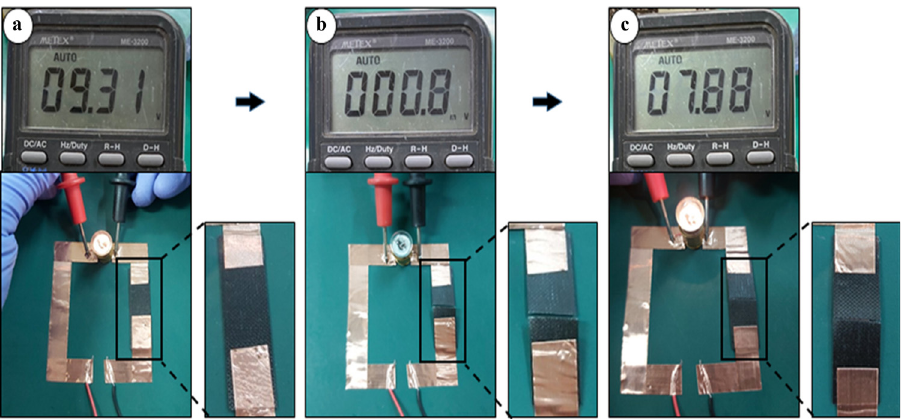
Figure 8: Digital images con fi rming the healing process through electric conductivity at ( a ) original, ( b ) damaged, and ( c ) healed